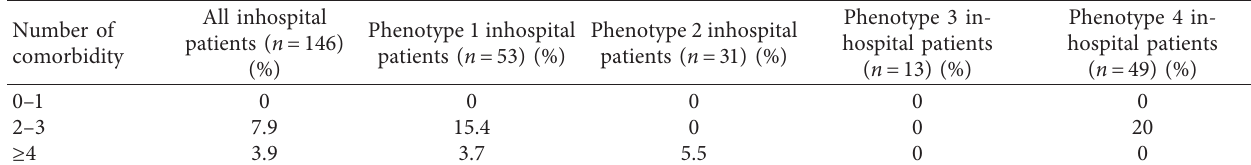
Table 3: Inhospital mortality according to number of comorbid diseases in four phenotypes.